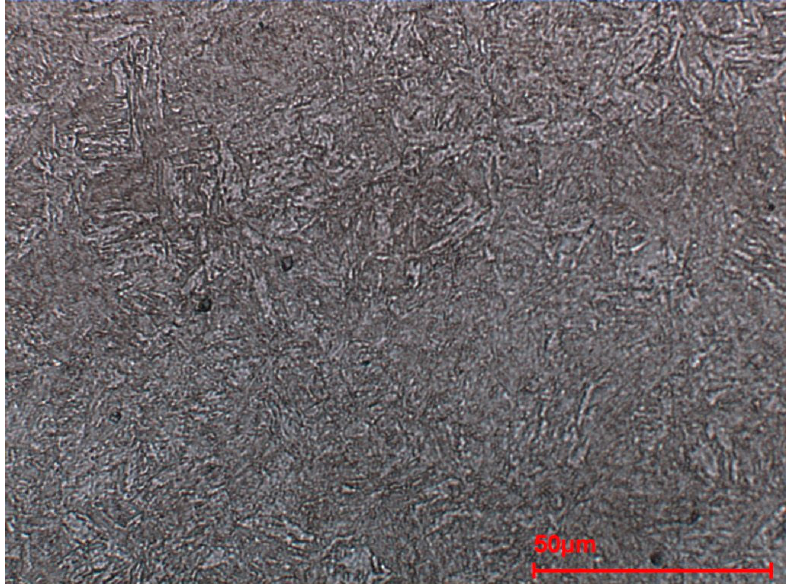
Figure 17. Microstructure of the chain grade R4 steel, composed of tempered martensite and bainite.